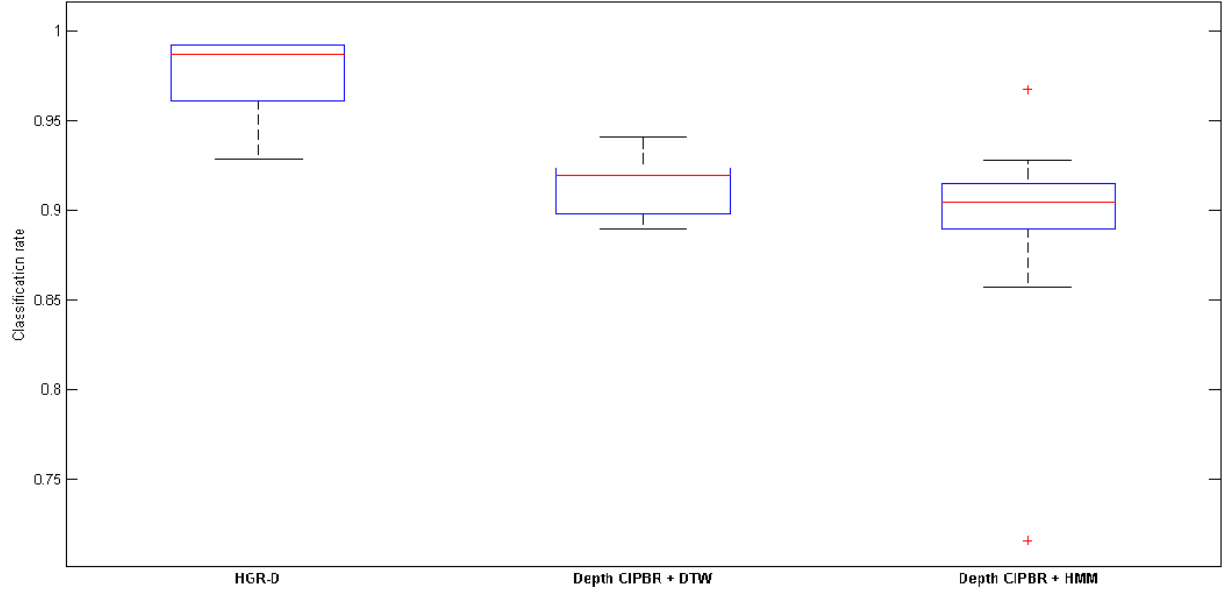
Figure 5. Comparison between HAGR-D, depth CIPBR with DTW and depth CIPBR with HMM for hand gesture